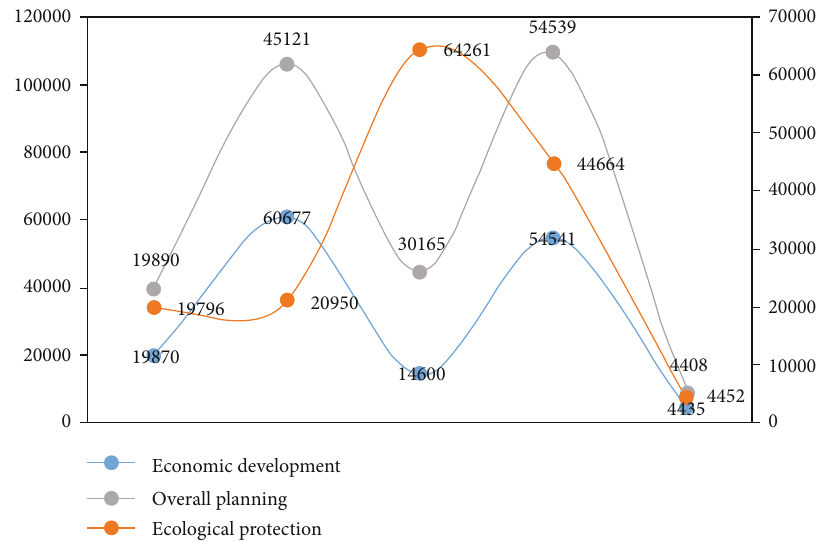
Figure 7: Results of the spatial optimization model for PSO landscape pattern in 2024 for each scenario.